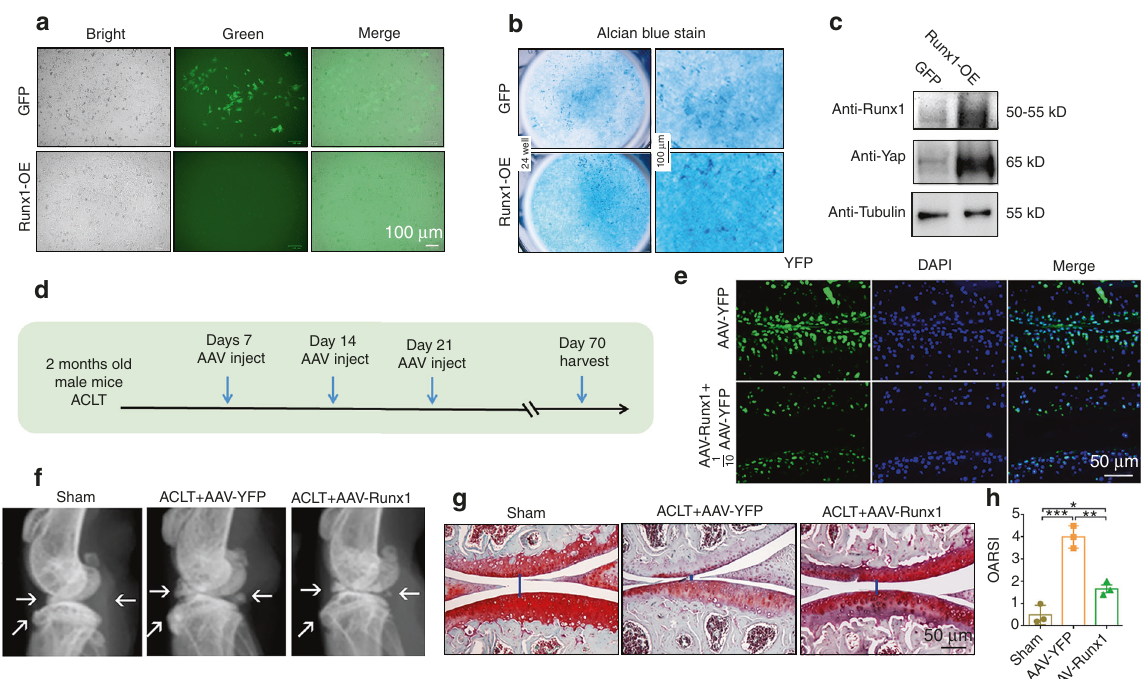
Fig. 6 Runx1 overexpression in chondrocytes promoted Yap expression in vitro, and local Runx1 overexpression by AAV protected against OA in an ACLT mouse model in vivo. a Images under a fl uorescence microscope. pMXs-GFP (GFP) and Runx1 overexpression (Runx1-OE) by pMXs- 3xFlag-Runx1 retrovirus transfection in ATDC5 cells that were induced to chondrocytes for 14 days. Bar: 100 μ m. b Alcian blue staining in ATDC5 cells that were induced to differentiate into chondrocytes for 14 days. Bar: 100 μ m. c Western blot of induced cells. d Schematic display of ACLT surgery-induced OA and subsequent AAV-Runx1/AAV-YFP treatment work fl ow. e Images under a fl uorescence microscope for YFP expression in treated mouse knee joints. Bar: 50 μ m. f Radiography results showed that AAV-Runx1 prevented ACLT-mediated OA. The arrow shows osteophytes and worn articular cartilage. g Knee joint safranin O (SO) staining of AAV-treated ACLT-mediated osteoarthritic knees. The blue line shows the space of the knee joint. Bar: 50 μ m. h OARSI score of ( g ). The results are presented as the mean ± SD, n = 3, * P < 0.05, ** P < 0.01, *** P < 0.001